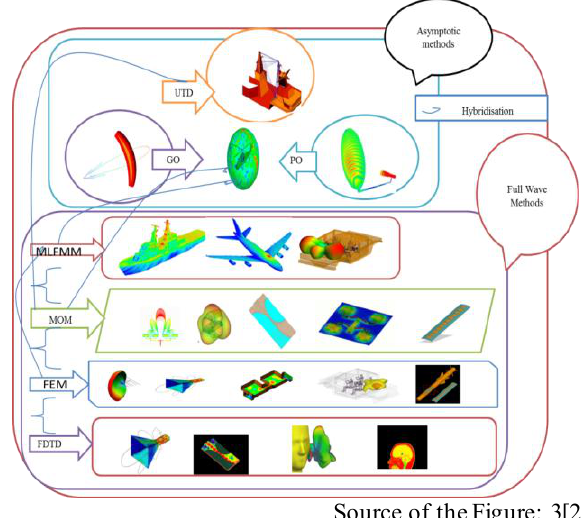
Figure : 3. Applications of computational Electromagnetics solvers, yield desired performance in CM analysis.